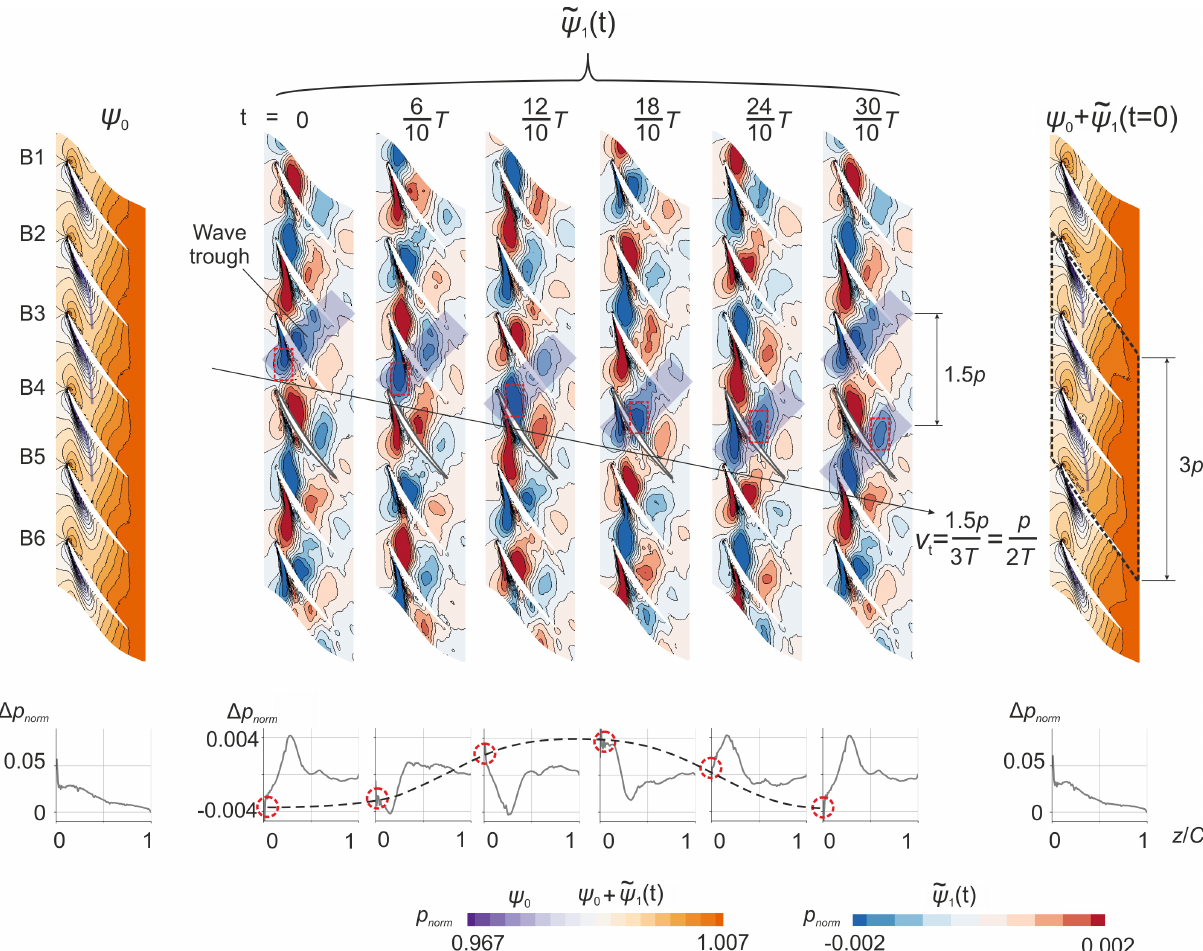
Figure 13. Ensemble-averaged pressure, temporal evolution of dominating mode, example of reconstructed pressure, and profile of blade pressure difference at 95% span for s / C = 4.3% at Φ = 0.51.